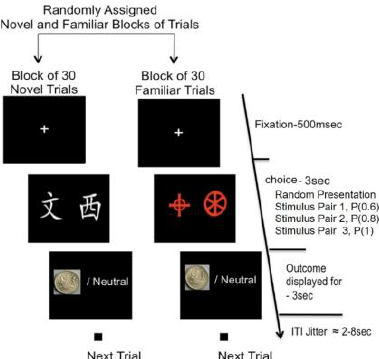
Figure 1. Probabilistic learning task used during pre-training and scanning sessions. Subjects were presented with two abstract visual stimuli (either familiar or novel pair). Subjects selected one of the stimuli, and their choice was followed by a probabilistic feedback on the screen displaying either a pound picture or written “neutral”.